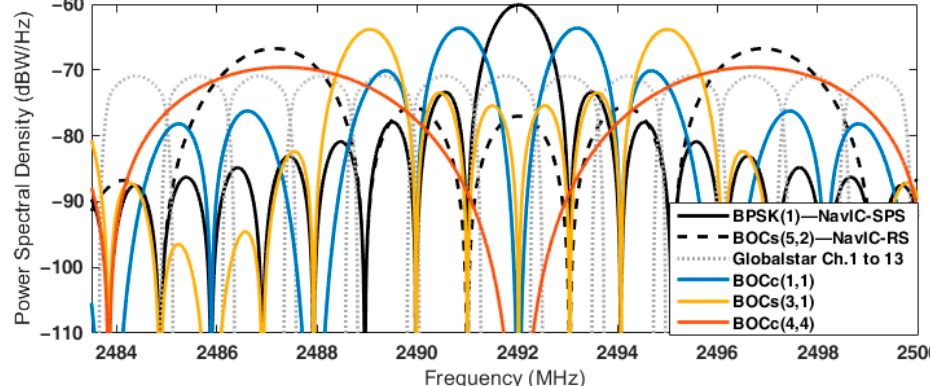
Figure 2. Normalized power spectral density (PSD) of NavIC, Globalstar, and candidate binary phased shift keying (BPSK) and binary offset carrier (BOC) signals in the S-band.